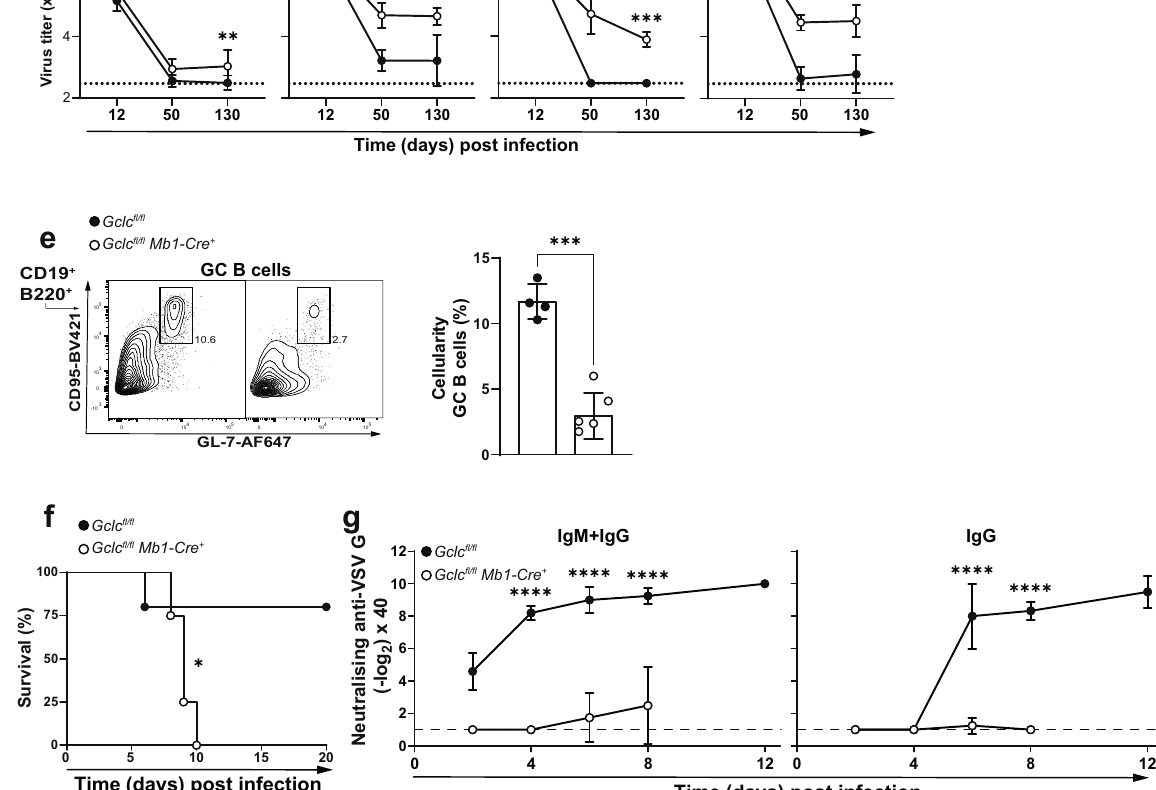
CI activity, in particular, requires adequate levels of reduced GSH in the mitochondria for its function 120,121 . GSH-dependent mitochondrial functions are in fl uenced by changes in levels of cytosolic GSH because GSH is synthesized in the cytosol and must be imported into the mitochondria to exert its function as antioxidant 122,123 . In addition to decreased CI, we found com- promised CII activity in Gclc -de fi cient B cells. Reduced